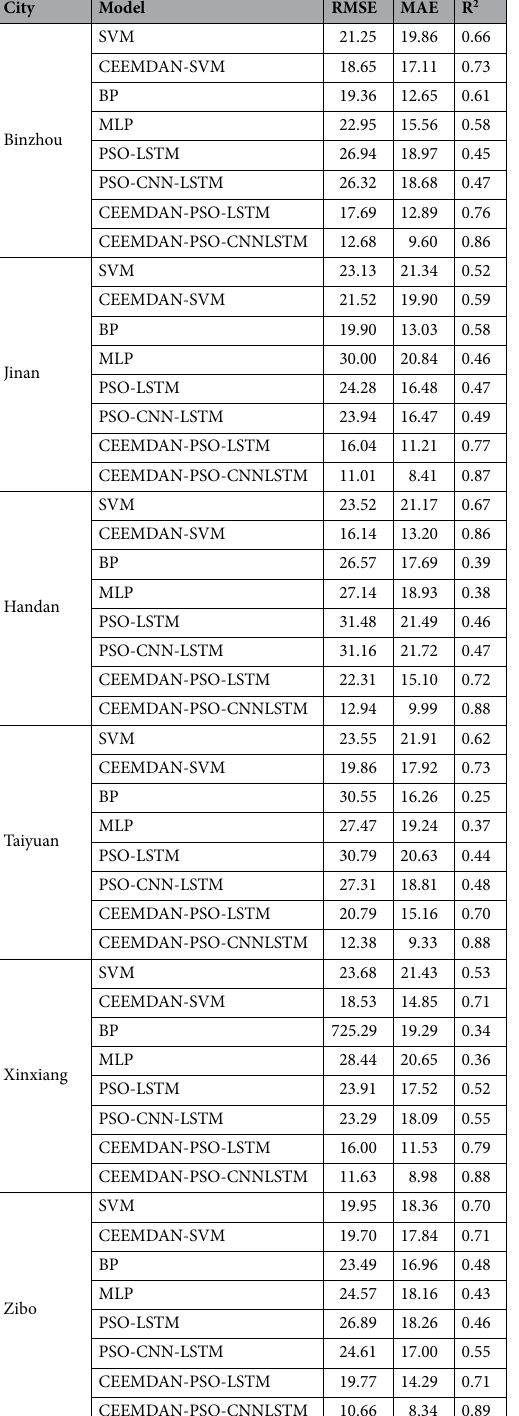
Table 4. The statistical evaluation of different model performances